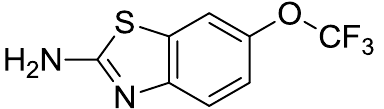
Figure 5. Structure of riluzole.